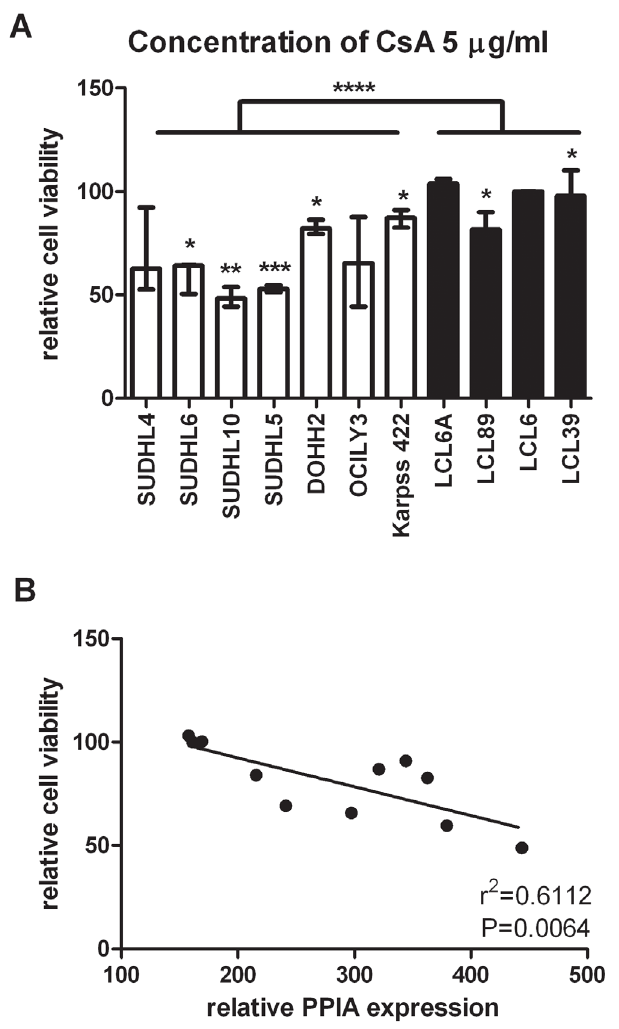
Fig 4. Sensitivity of NHL and LCL cell lines to inhibition of PPIA by 5 μ g/ml CsA. (A) The inhibition of cell viability after CsA treatment. After adding 5 μ g/ml CsA for 72 hours, the viability of NHL and LCL cell lines was evaluated by alamar blue assay. A paired T-test was performed to compare the cell viability before and after treatment. Mann-Whitney U test was used to compare the cell viability between the NHL cell line group and LCL group. ( * : p < 0.05; ** : p < 0.01; *** : p < 0.001; **** : p < 0.0001) (B) The correlation between PPIA expression level and the inhibition of cell viability after NHL cell lines treated with 5 μ g/ml CsA for 72 hours. Statistical significance was determined by Spearman test (p = 0.0064, r 2 = 0.6112). There is a negative correlation between the relative PPIA expression and the % of viability after CsA